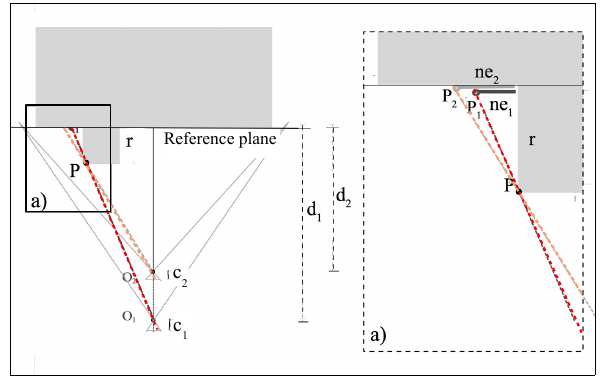
Figure 6. Relief displacement n e 1 and n e 2 on the reference